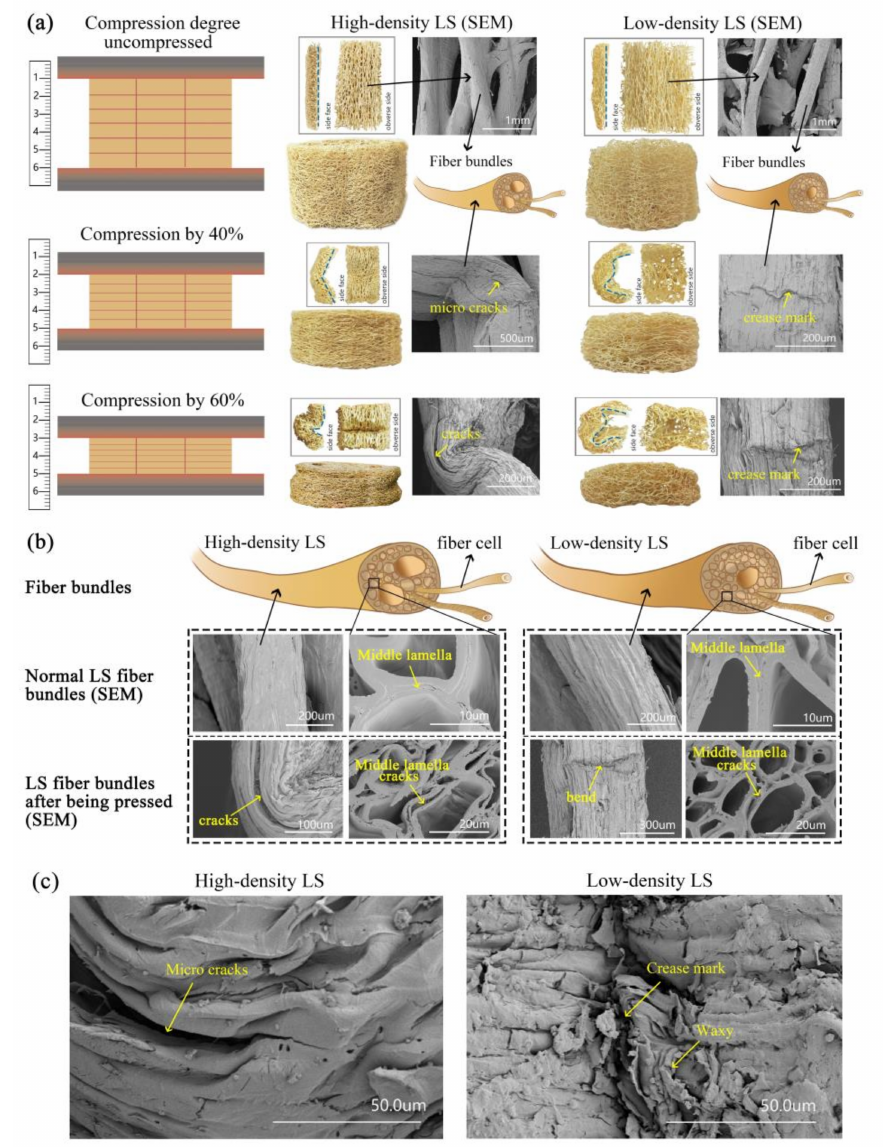
Figure 5. The morphology of the two types of LS columns and their fiber bundles: ( a ) the surface morphology of LS columns compressed to different degrees and the micro morphology of their inner fiber bundles, ( b ) the morphology of a fiber cell section before and after the compression of LS columns and ( c ) the surface morphology of HD and LD LS columns.